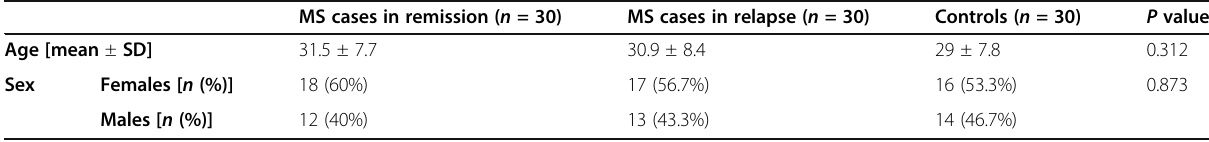
Table 1 Age and sex distribution in MS cases and controls MS cases in remission ( n =